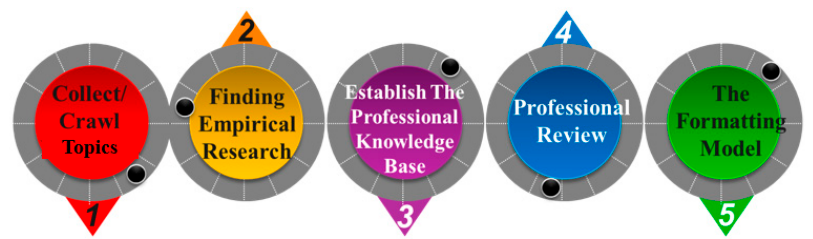
Figure 2. Five steps of EBM.